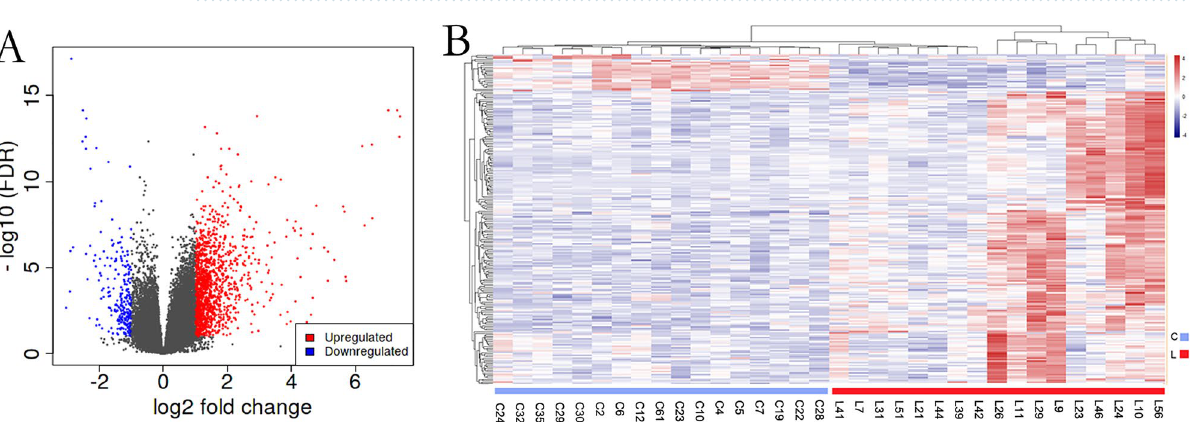
Figure 4. The discrepancy between HCC and healthy controls in terms of gene expression profile. It was created using iDEP version 0.92, http:// bioin forma tics. sdsta te. edu/ idep/. ( A ) The plot and the dispersion of the volcano that shows the mRNA differential expression between HCC and NC. The red (up) and blue (down) sites reflect the differentially expressed RNAs with fold threshold ≥ 2.0 and p-Value < 0.05; ( B ) DEGs hierarchical evaluation for clustering in HCC